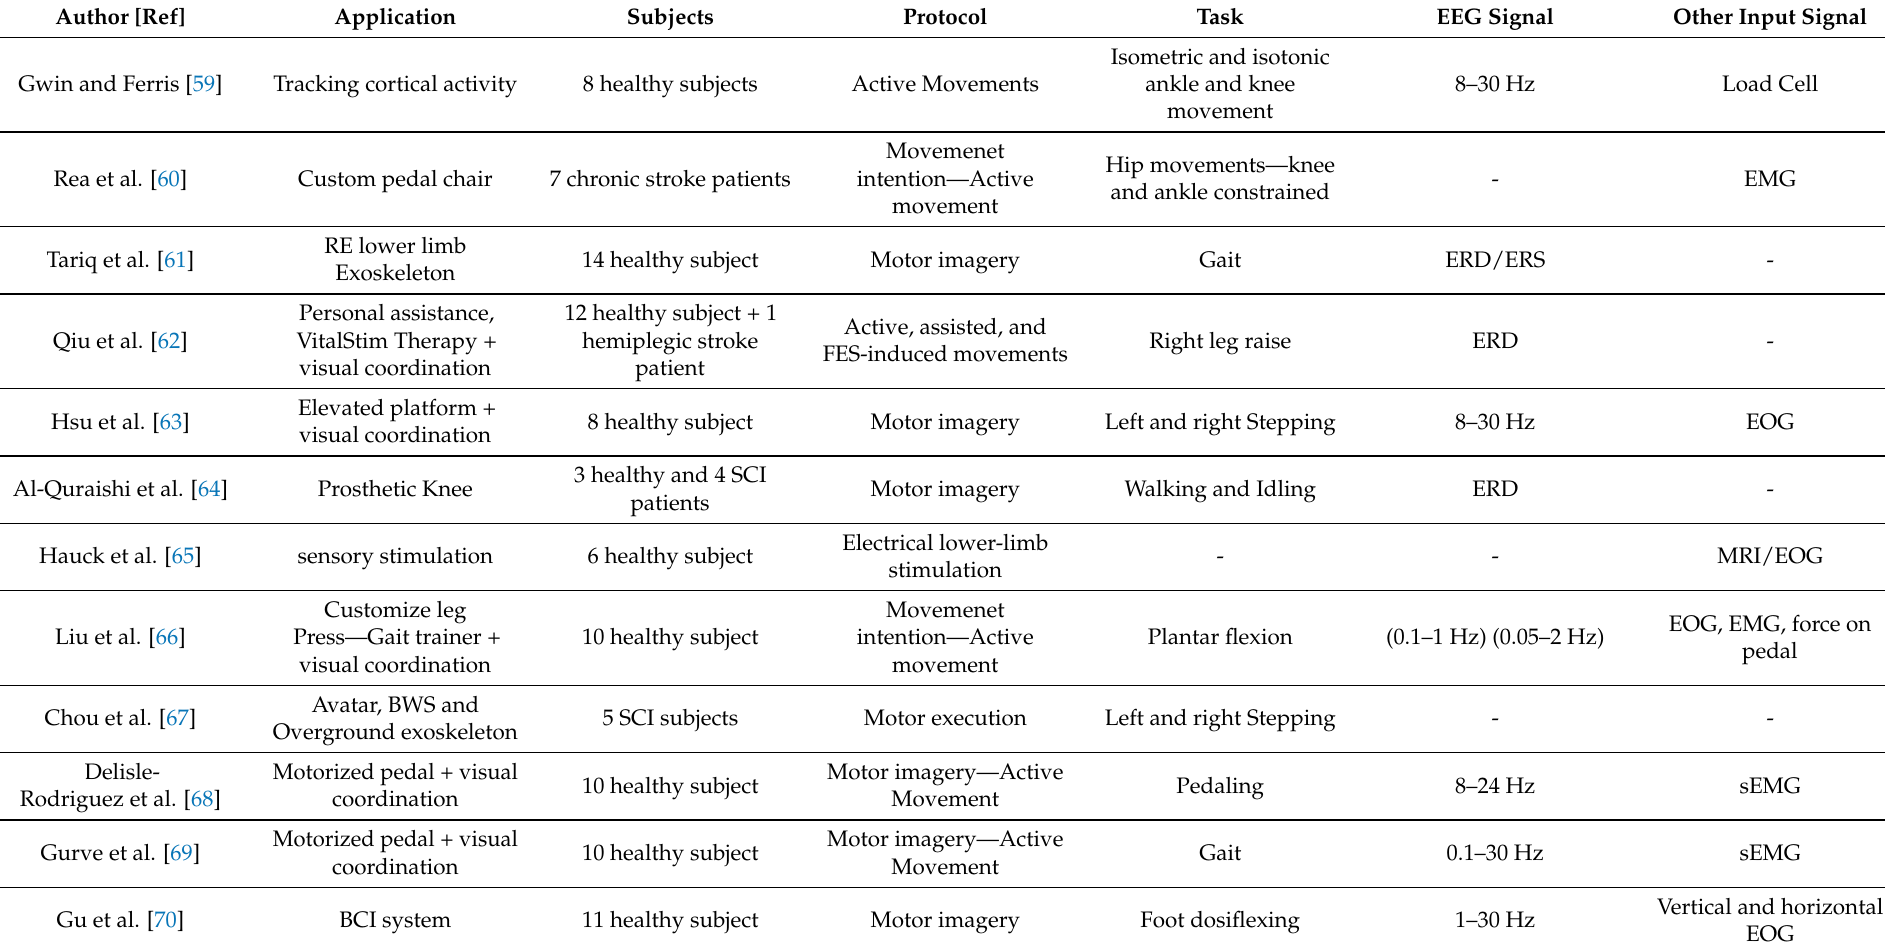
Table 2. EEG-based control for lower limb